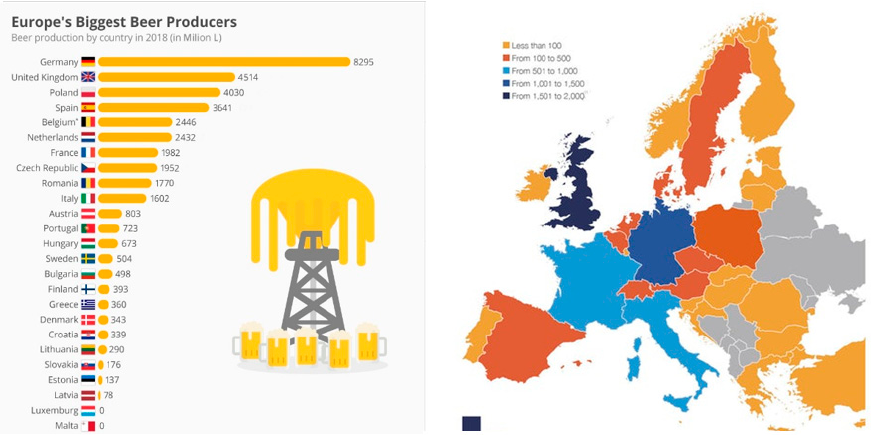
Figure 5. European Beer Producers (Eurostat 2020) and Breweries geographical distribution.